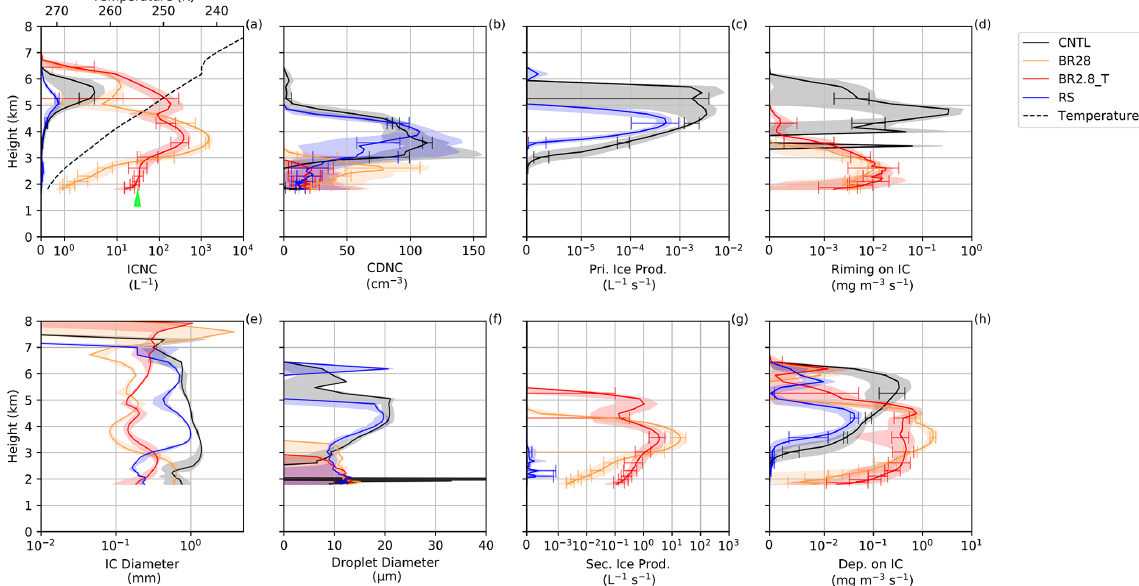
Figure 5. (a, e) Ice crystal number concentration (ICNC) and diameter, (b, f) cloud droplet number concentration (CDNC) and size, (c, g) pri- mary and secondary ice production and (d, h) riming and depositional (Dep.) growth of ice at Gotschnagrat at 13:00UTC. The solid lines are the model mean, with error bars showing the model spread for each simulation. The shaded regions are the minimum and maximum values for the four closest model points. The mean ice diameter is denoted by IC. The green arrow is the average ICNCs from the HoloGondel measurements (Fig.